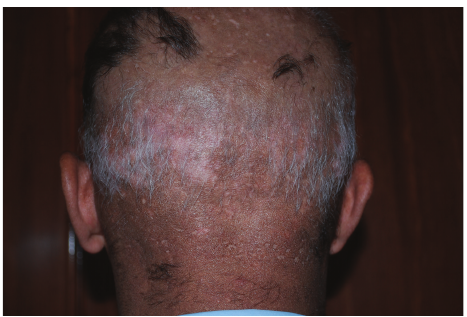
Figure 1: Vitiligo patches on scalp with white hair.